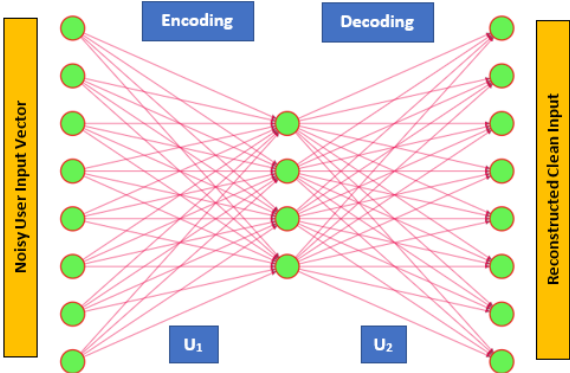
Figure 3. Neural network of a denoising auto ‐ encoder for an RS .